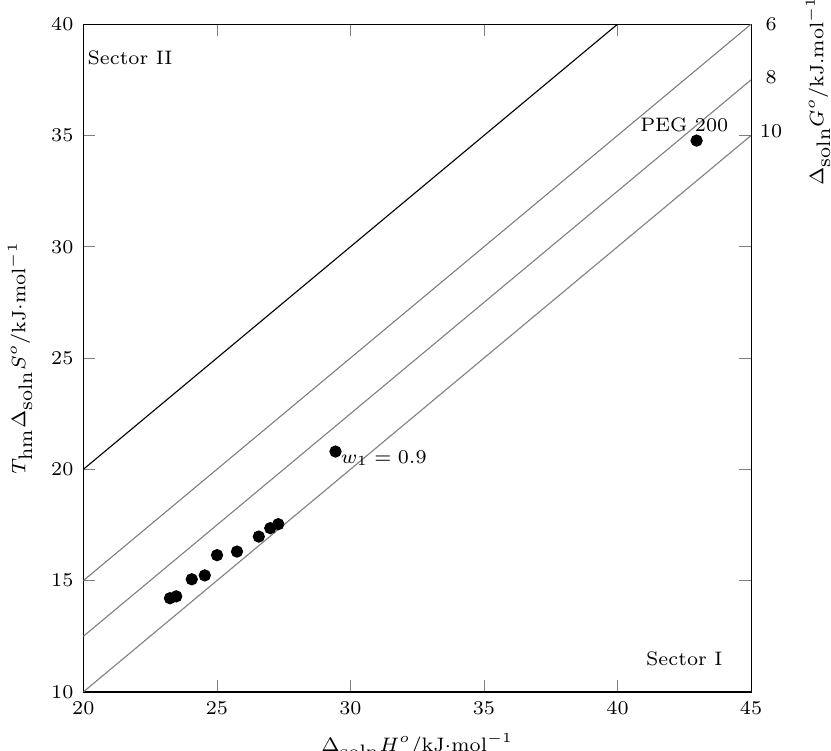
Figure 8. Relation between enthalpy ( ∆ soln H o ) and entropy ( T hm ∆ soln S o ) in terms of the process of isoniazid (3) solution in (PEG 200 (1) + water (2)) cosolvent mixtures at 297.6 K. The isoenergetic curves for ∆ soln G o are represented by dotted